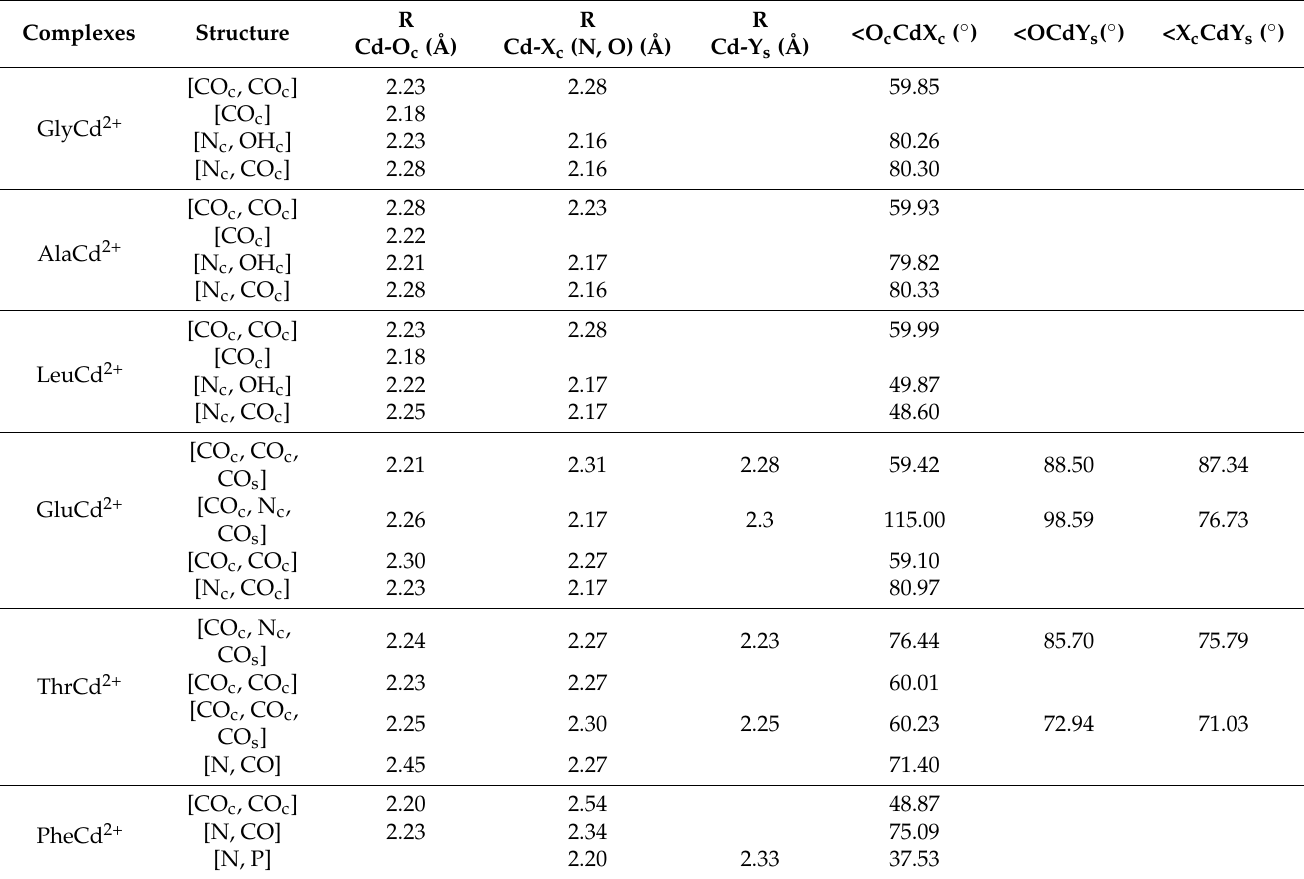
Table 3. Calculated bond lengths and bond angles of the amino acid-Cd